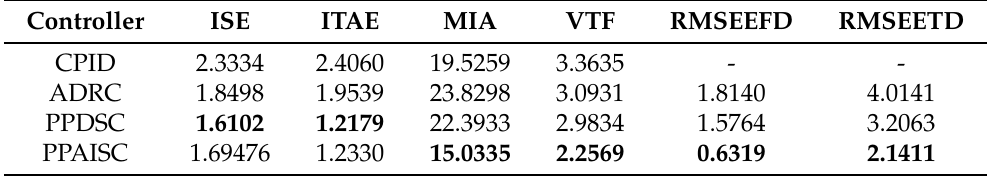
Table 2. The performance comparisons of different control